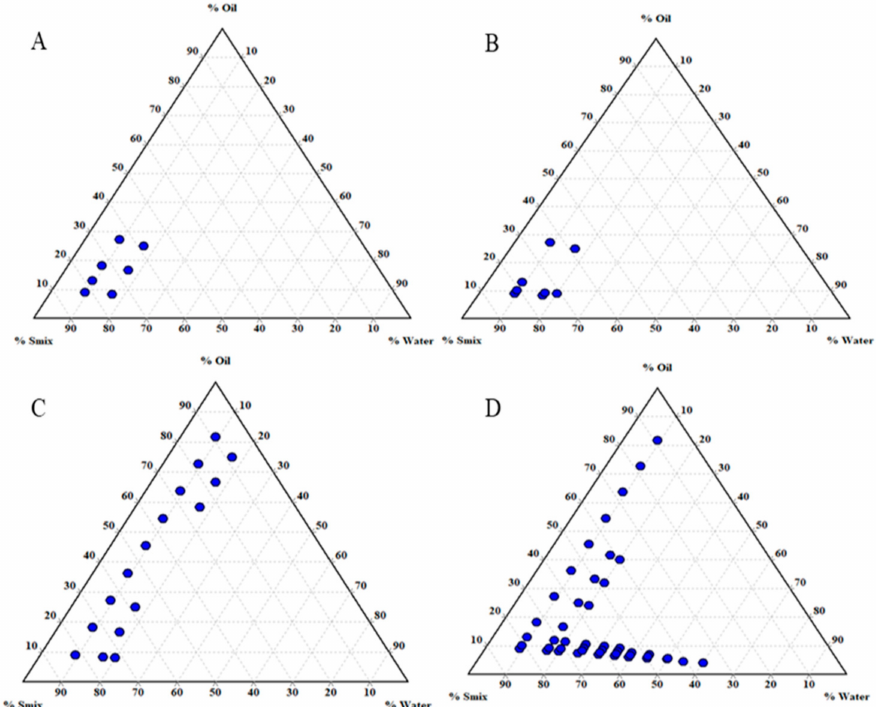
Figure 2. Ternary phase diagrams of nanoemulsions consisting of ethyl oleate and Tween 20 with different cosurfactants: ( A ) isopropyl alcohol; ( B ) propylene glycol; ( C ) Transcutol P; ( D ) Labrasol at a 1:1